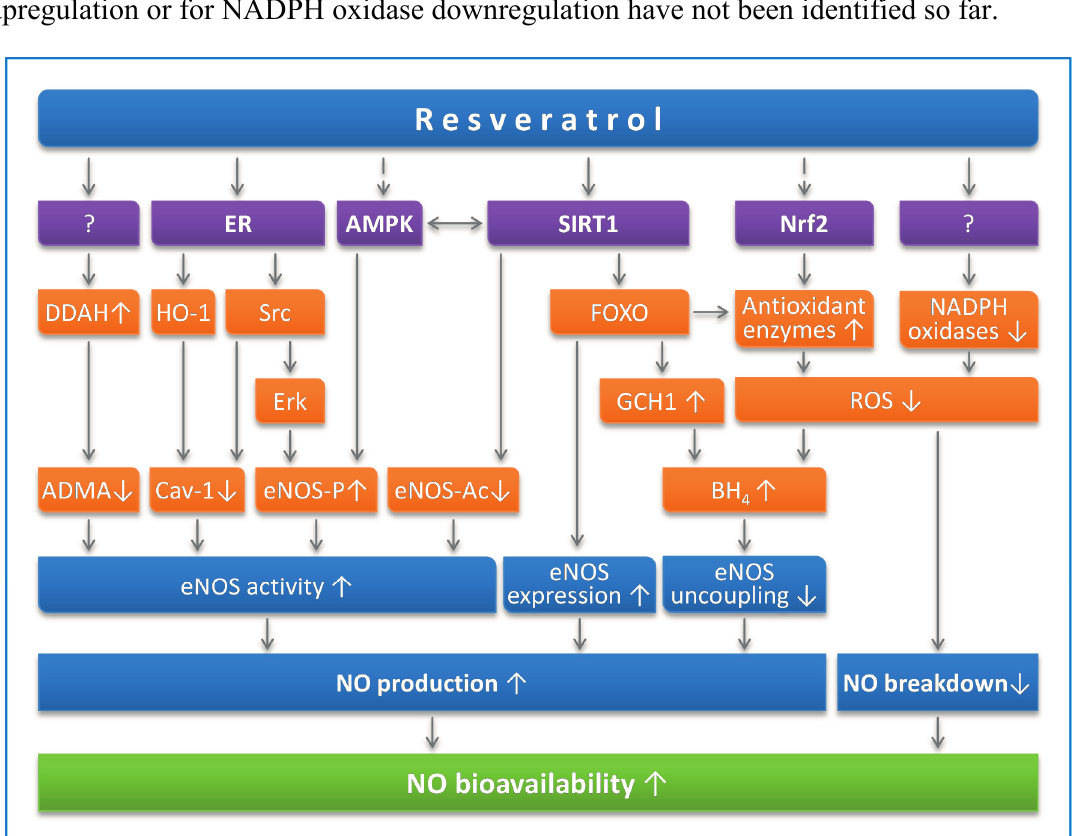
Figure 1. Resveratrol enhances NO production and prevents NO breakdown. Resveratrol can activate sirtuin 1 (SIRT1) directly (in a substrate-dependent manner) or indirectly (by either inhibiting phosphodiesterases or enhancing the effect of lamin A). SIRT1 stimulates endothelial NO synthase (eNOS) activity through deacetylation, enhances eNOS expression by deacetylating Forkhead box O (FOXO) transcription factors and prevents eNOS uncoupling by upregulating GTP cyclohydrolase 1 (GCH1), the rate-limiting enzyme in tetrahydrobiopterin (BH 4 ) biosynthesis. AMP-activated protein kinase (AMPK) and nuclear factor-erythroid-derived 2-related factor-2 (Nrf2) are indirect targets of resveratrol. AMPK phosphorylates eNOS at serine 1177. eNOS can also be phosphorylated by Erk1/2, which is stimulated by a pathway involving estrogen receptors (ER) and the tyrosine kinase Src. Caveolin-1 (Cav-1) is an eNOS-interacting protein that negatively regulates eNOS activity. Asymmetric dimethylarginine (ADMA) is an endogenous eNOS inhibitor that is degraded by dimethylarginine dimethylaminohydrolase (DDAH). The resveratrol targets for DDAH upregulation or for NADPH oxidase downregulation have not been identified so